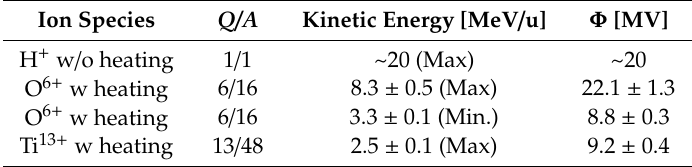
Table 1. Accelerated kinetic energies and the corresponding potentials Φ for typical ion species with the CW laser heating. The energy and potential for proton without the heating are estimated using the spot-size scaling [34]. Q /